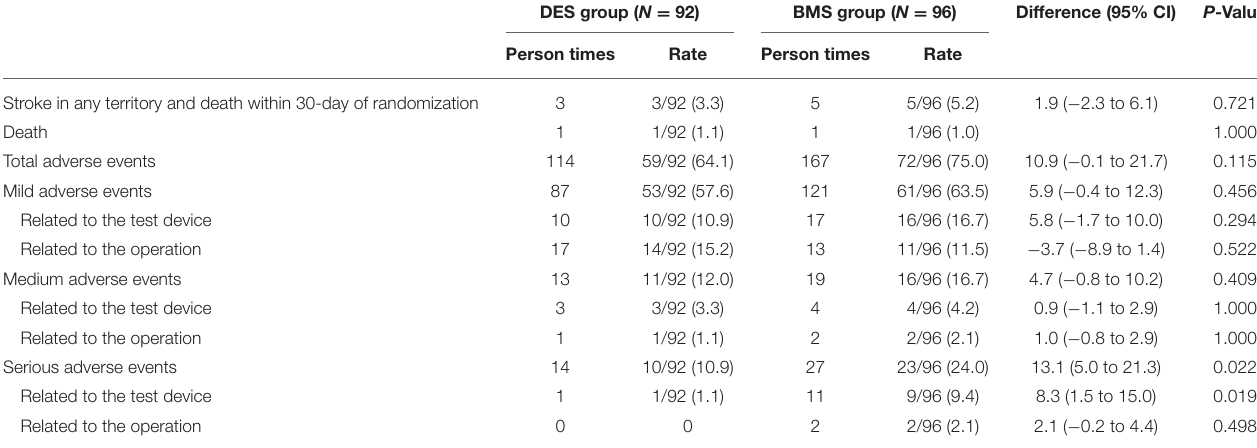
TABLE 3 | Safety endpoints in the intent-to-treat